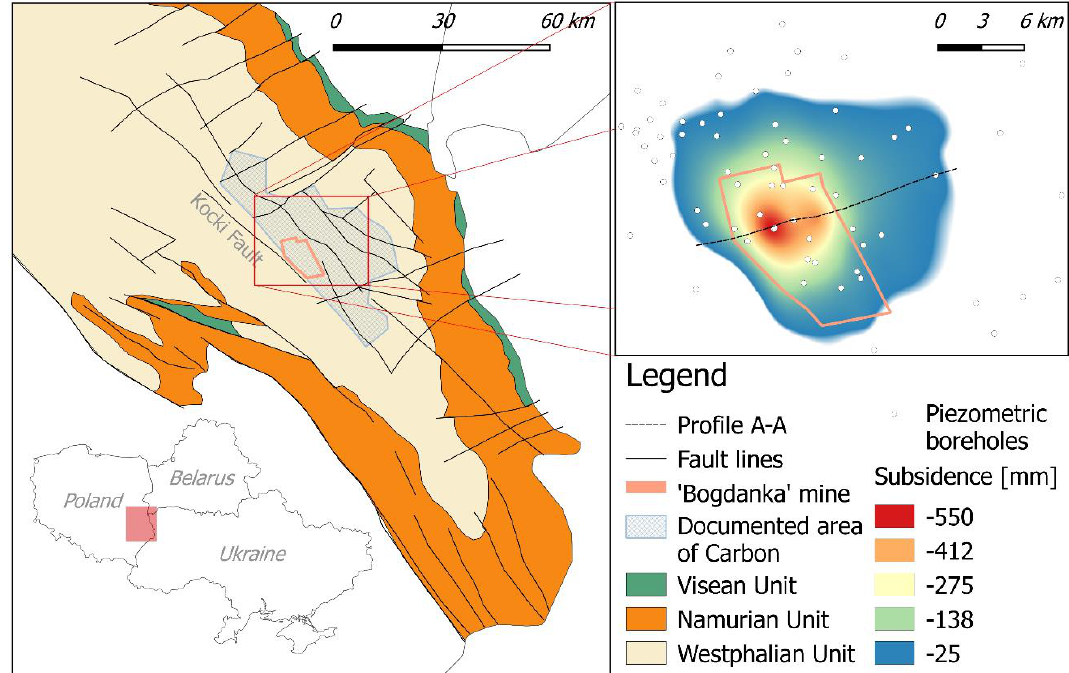
Figure 5. Location of the hard coal mine and the regional tectonics of the area. Piezometric boreholes and a large dewatering trough in the deep extraction area are shown. Condition as of 2011.